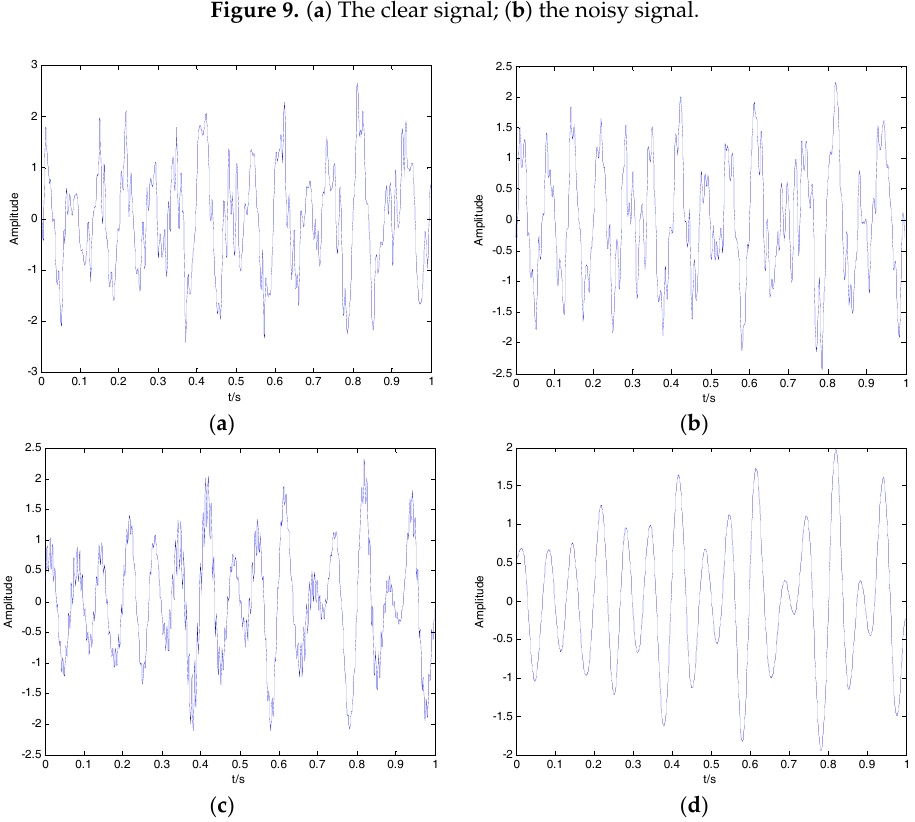
Figure 10. The denoising results of EMD, EEMD, VMD and 2VMD for the noisy signal. ( a ) EMD; ( b ) EEMD; ( c ) VMD; ( d ) 2VMD. Table 6. The SNR and RMSE for EMD, EEMD, VMD and 2VMD denoising. Noisy Signal EMD EEMD VMD 2VMD SNR/db